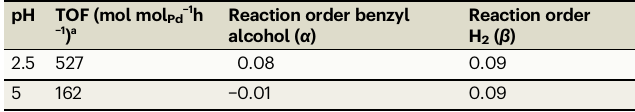
Table 1 | Summary of reaction rates and reaction orders